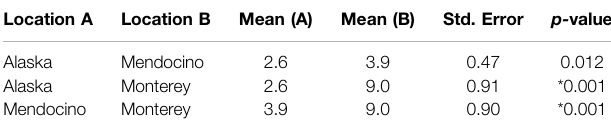
TABLE4| ResultsfrompairwiseTukey ’ sHSDpost-hoctestforregionspeci fi cbull kelp bulb diameters. *denotes signi fi